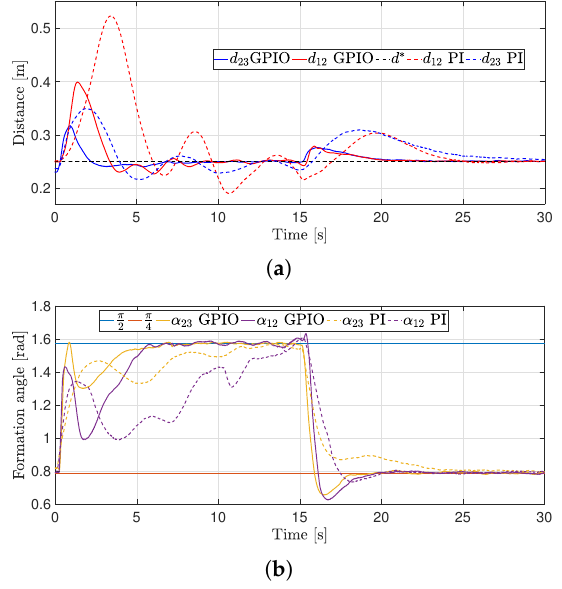
Figure 6. Distances and formation angles between the robots for the first experiment. ( a ) Distances between the robots. ( b ) Formation angles between the robots.